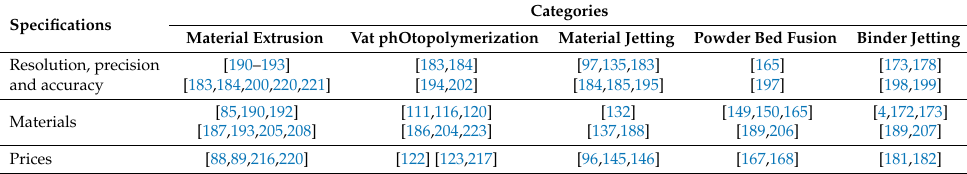
Table 6. Classification of references used in the text according to certain topics